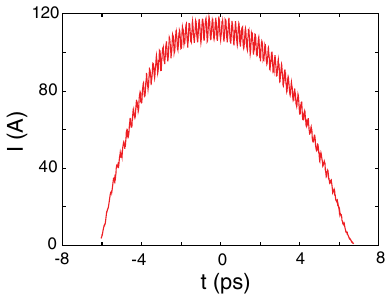
FIG. 2. Initial longitudinal beam current